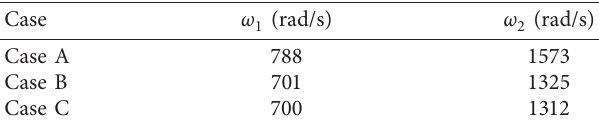
Table 4: Synchronous forward critical speeds induced by